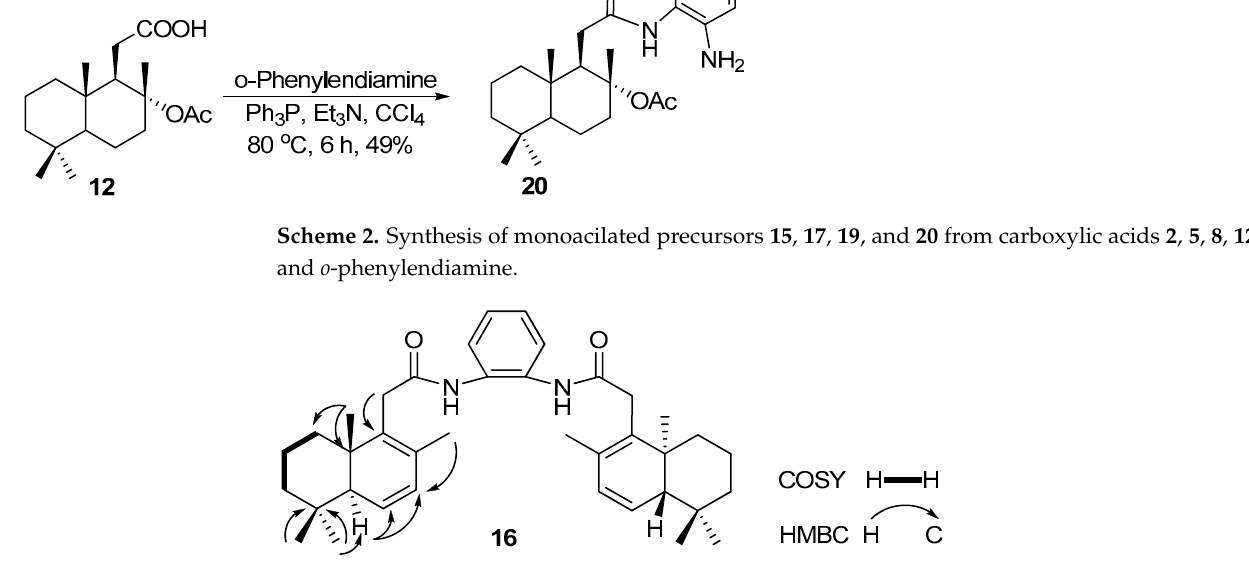
Figure 1. Selected COSY and HMBC correlations for compound 16 .